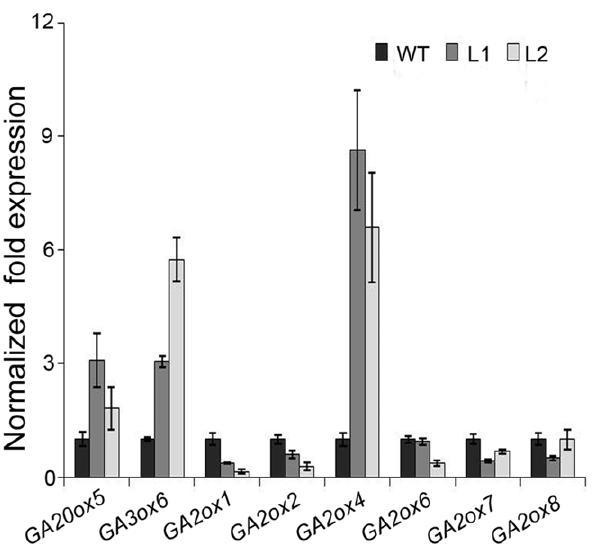
Figure 4. Expression levels of GA metabolism related genes. b - Tubulin was used as an internal control. GA20ox5 : GmGA20ox5 (Glyma13g09460); GA3ox6 : GmGA3ox6 (Glyma17g30800); GA2ox1 : GmGA2ox1 (Glyma02g01330); GA2ox2 : GmGA2ox2 (Glyma10g01380); GA2ox 4: GmGA2ox4 (Glyma11g00550); GA2ox6 : GmGA2ox6 (Gly- ma13g33290); GA2ox7 : GmGA2ox7 (Glyma13g33300); GA2ox8 : GmGA2ox8 (Glyma15g10070). Values are the mean of four biological replicates 6 SE.